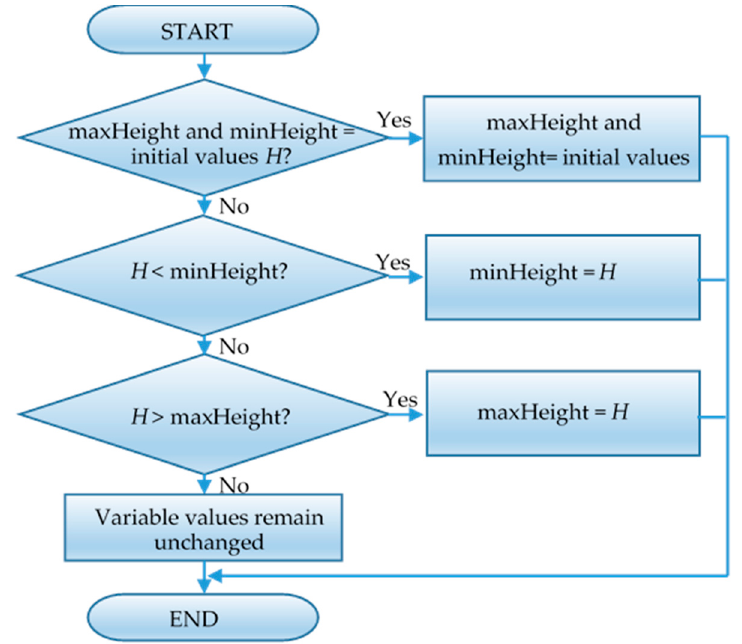
Figure 15. Node height information update flowchart ( H = the height of the collision point).